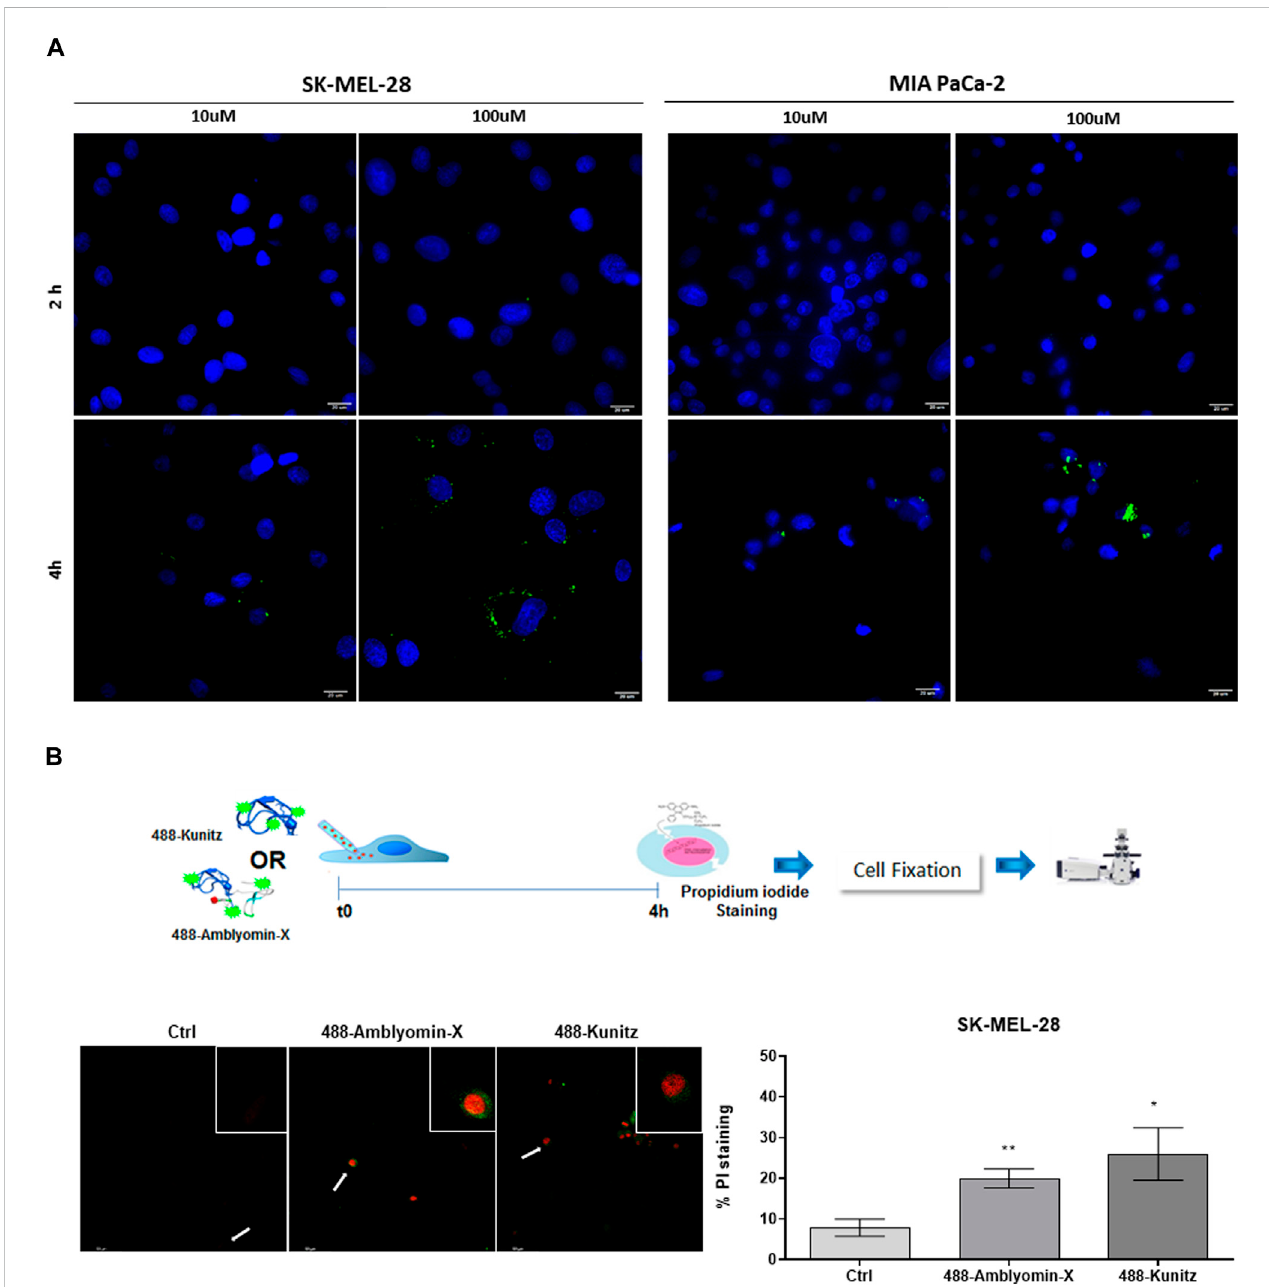
FIGURE 6 Kunitz is slightly uptake by tumor. (A) Cells were incubated with 488-Kunitz (10 μ M and 100 µM) for 2 and 4 h. Green fl uorescence was monitored by a Molecular Devices ImageXpress Micro Confocal plate-scanning microscope. Nuclei stained with Hoechst 333422. Kunitz vesicles were analyzed using MetaXpress software (Molecular Devices, Sunnyvale, CA). (B) Cells were microinjected with 488-Kunitz or 488-Amblyomin-X, both at 20 μ M, and incubated for 4h, when cell death was scored, based upon green fl uorescence and PI